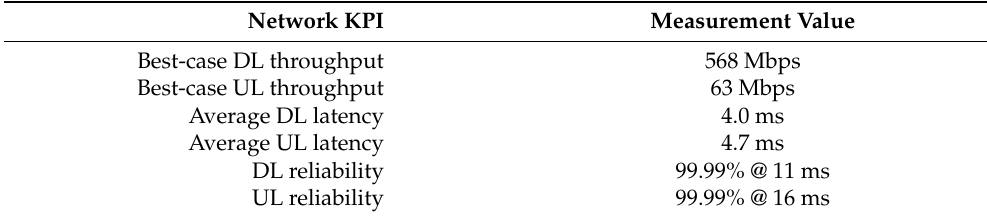
Table 4. Measured performance of a Rel-15 5G test